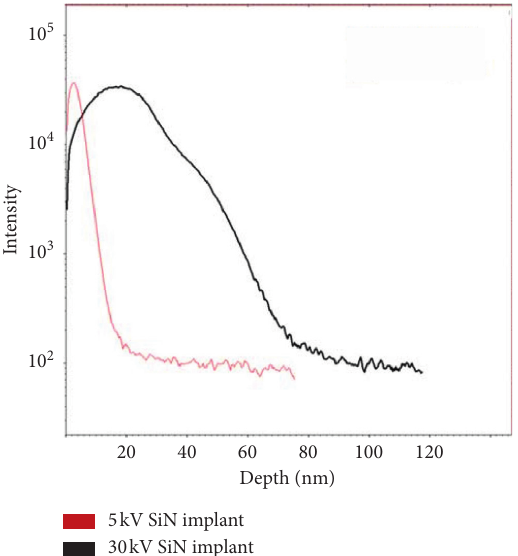
Figure 5: TOF SIMS data of the silicon region milled with N + at 5kV and 30